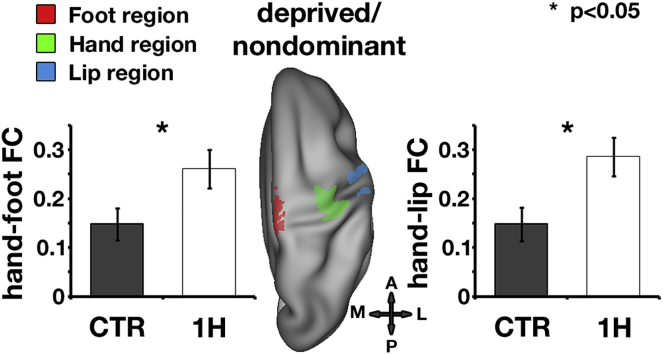
Reorganization Observed in One-Handers’ Resting-State Functional ConnectivityROIs of the foot (red), hand (green), and lip (blue) are projected onto an inflated surface of a template brain, representing the deprived/nondominant hemisphere from a dorsal view. Functional connectivity was increased between the missing-hand territory and the foot (left) and lip (right) ROIs in one-handers (white bars) compared to controls’ nondominant-hand territory (gray bars). Error bars depict SEM. FC, functional connectivity. Other annotations are as in Figure 2.See also Figure S2.